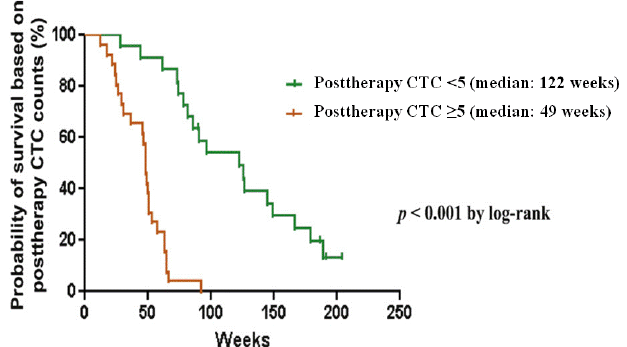
Figure 2. CTC count and survival in castration-resistant prostate cancer. Probability of survival stratified by post-treatment CTC count. CTC count ≥5 at 4 weeks was associated with shorter overall survival compared with patients with CTC counts of <5 (reprinted from [39] with permission of Elsevier).